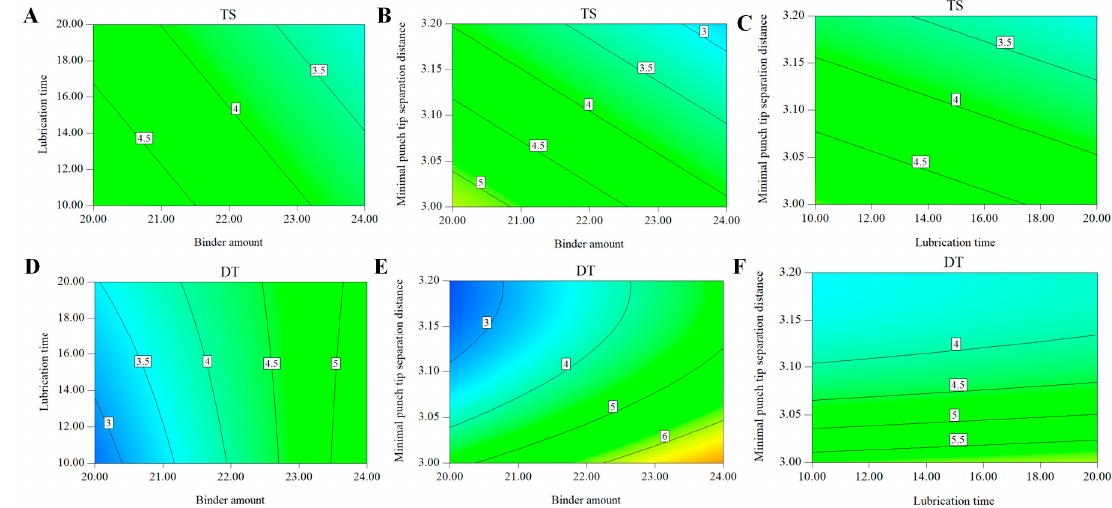
Figure 12. Contour plot showing the effects of the binder amount, lubrication time, and minimal punch tip separation distance on the tensile strength and disintegration time.